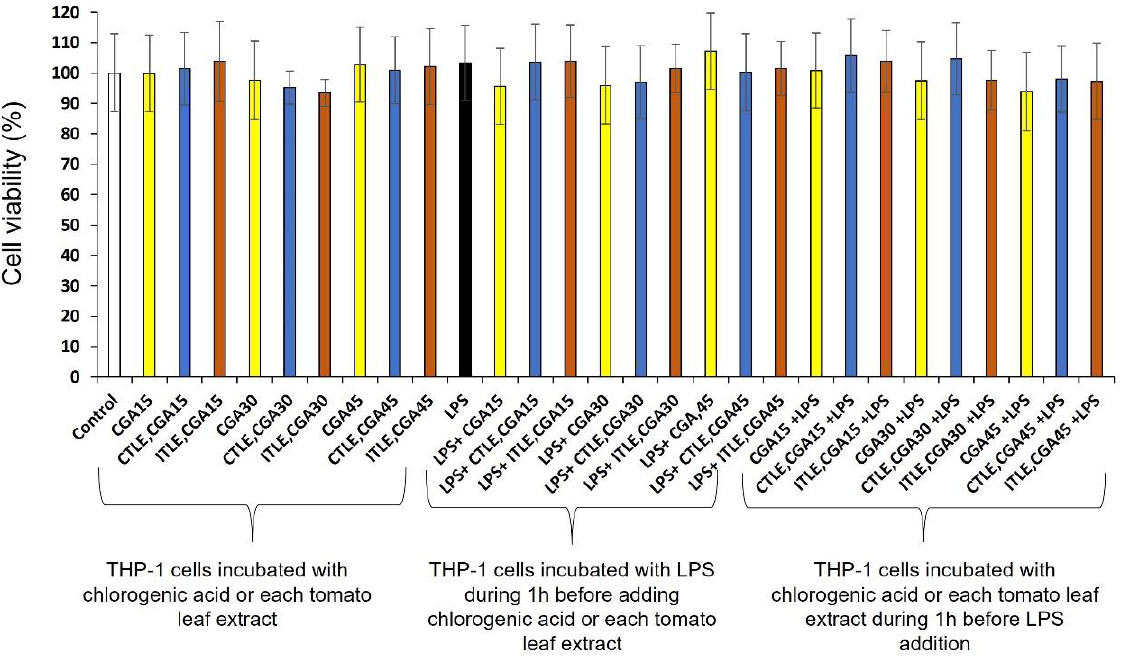
Figure 5. Effects of tomato leaf extracts on the viability of differentiated THP-1 cells. Extracts of tomato leaves infested (ITLE) or not (CTLE) with T. absoluta were evaluated. Three concentrations of tomato leaf extracts (50, 100 and 150 µg/mL) in which chlorogenic acid (CGA) concentrations, the major phenolic compound, represent, respectively, 15, 30 and 45 µg/mL were used. Differentiated THP-1 cells were incubated with CGA or a tomato leaf extract alone or with 100 ng/mL of LPS added one hour before or after the addition of the tomato leaf extract or CGA. Twenty-four hours later, THP-1 cell viability was analyzed by crystal violet assay and optical density (O.D.) was measured at 595 nm. “Control” corresponds to a THP-1 cell culture in which no product was added (negative control). “LPS” corresponds to a THP-1 cell culture in which only LPS was added (positive control). “LPS + tomato leaf extract,15” indicates that LPS was added before tomato leaf extract in which the CGA concentration was 15 µg/mL while “tomato leaf extract,15 + LPS” indicates that tomato leaf extract in which the CGA concentration was 15 µg/mL was added before LPS. This figure is representative of six independent experiments performed in triplicates. Data are presented as the mean ± S.D. t-tests were used to identify statistically significant differences.